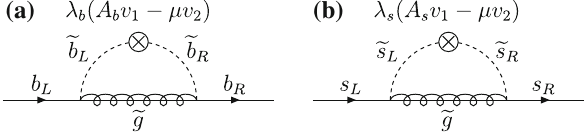
Fig. 1 One-loop diagrams of the SUSY–QCD contributions to a the bottom and b the strange self-energies with the off-diagonal mass inser- tions related to the (cid:9) q ( q = b , s ) corrections of the bottom- and strange-Yukawa couplings. The contributing particles involve bottom and strange quarks b , s and squarks ˜ b , ˜ s as well as gluinos (cid:19) g (cid:18) (cid:17) O (α ) n . For the bottom-Yukawa coupling a resum- (cid:18) (cid:17) s A b , s (λ 2 A t tg β) n terms is achieved in addition mation of the O t [39,40] (including mixed